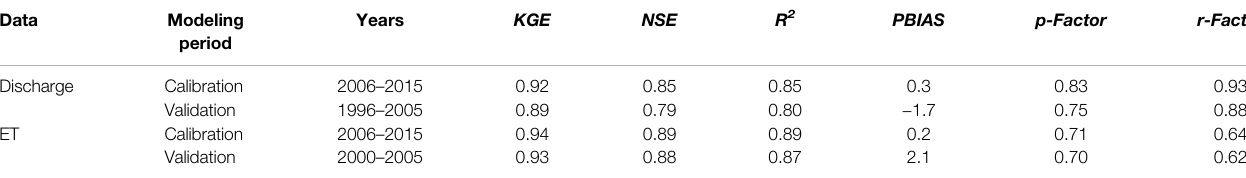
TABLE 3 | Results of the simulated evaluation and uncertainty analysis of the discharge and ET in the SWAT calibration and validation periods in the Xiangjiang River